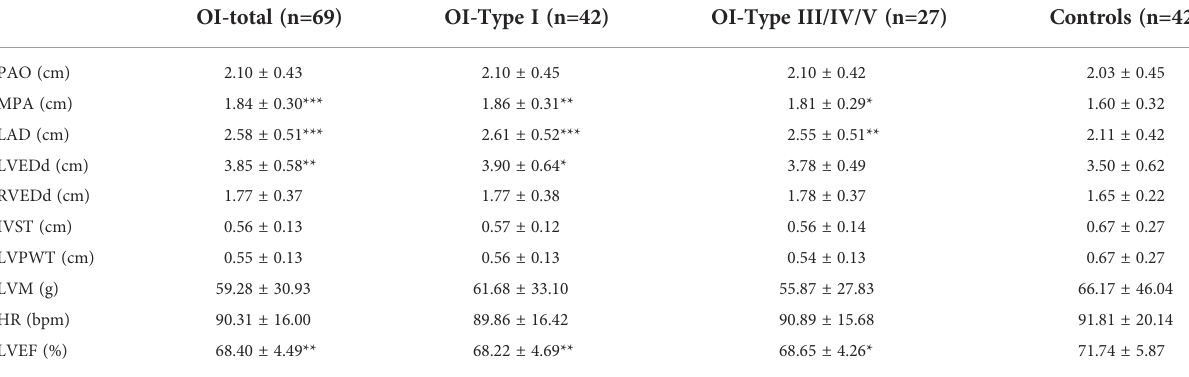
TABLE 3 Echocardiographic parameters in OI patients and controls.